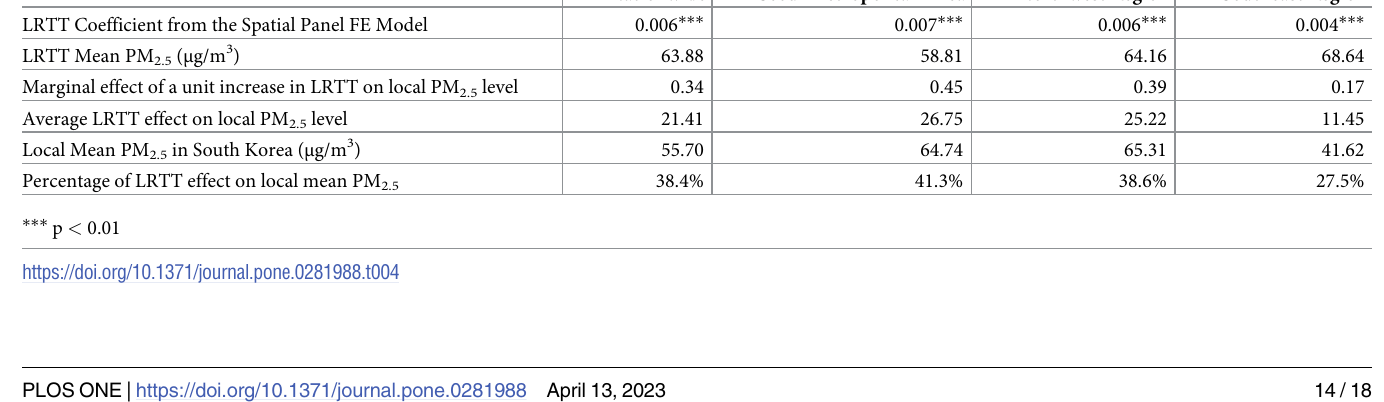
Table 4 presents the average effects of LRTT from China on the nationwide and three local PM concentrations. Calculating the average effects of LRTT from China on the local PM 2.5 2.5 concentrations requires several steps. First, since we took a natural log of local PM concen- 2.5 tration as dependent variable, the percent change in local PM level for a unit increase in the 2.5 LRTT can be obtained from the coefficient of the LRTT. Second, the marginal effect of a unit increase in LRTT on the local PM level can be computed by multiplying the percentage 2.5 change by the Korean average PM level and dividing by 100. Third, multiplying this by aver- 2.5 age LRTT yields the average LRTT effect on local PM level. The average effects of LRTT 2.5 from China were 21.4 μ g/m 3 , 26.8 μ g/m 3 , 25.2 μ g/m 3 , and 11.5 μ g/m 3 on the nationwide, the Seoul Metropolitan Area, the northwest, and the southeast regions, respectively, which account